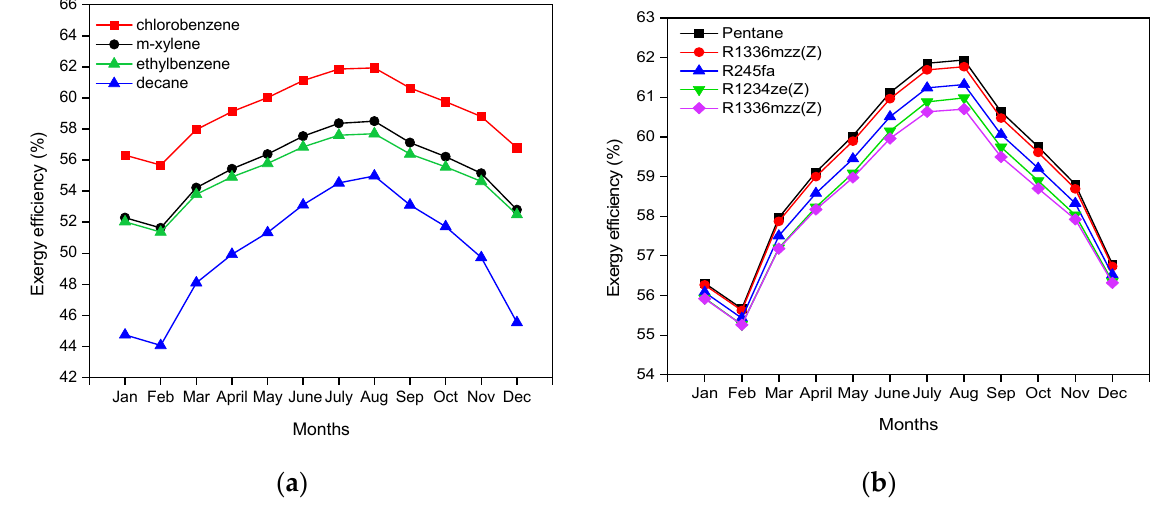
Figure 3. Exergy efficiencies for different months. ( a ) SORC; ( b ) RORC. To analyse the optimal working fluid for the RORC, chlorobenzene was set as fluid 1, and a set of five different working fluids [R245fa, R601, R236fa, R1234ze (Z), and R1336mzz (Z)] was examined for fluid 2. The exergy curves are shown in Figure 3. As shown in Figure 3b, R601 exhibited the most favourable results. Fluid 1 influenced the exergy efficiency of the cycle more than fluid 2. However, the substitution of fluid 2 by any of the examined working fluids had a minimum effect on exergy as shown in the graph in Figure 3a,b. Exergy efficiency ranged from a minimum of 55.6% to 61.9% in August while winter had a relatively low efficiency. Hence, chlorobenzene was selected as fluid 1 and R601 as fluid 2 in this study. To analyse the total net shaft power, the same set of four working fluids in the SORC was studied keeping fluid 2 constant as R601 in all cases. Chlorobenzene shows promising results based on the net shaft power as shown in Figure 4a and was selected as fluid 1. Figure 4b indicated R601 as efficient fluid 2 based on the total net shaft curves. The total shaft power generated via turbines ranged from a minimum of 497.7 kW in January to 585.7 kW in August. Less power was generated in winter than in summer. In winter, the WHS requires more water to heat; therefore, it requires more energy. Energy from the turbine was used to heat water in the WHS supplied via fluid 1. The mass fraction of fluid 1 ‘x’ heated the water, and the fraction ‘1-x’ powered the RORC operation. Changes throughout the year and the change in the generated total shaft power were analysed. It was observed that power generation remained constant via turbine 1, whereas power generated by turbine 2 fluctuated throughout the year.